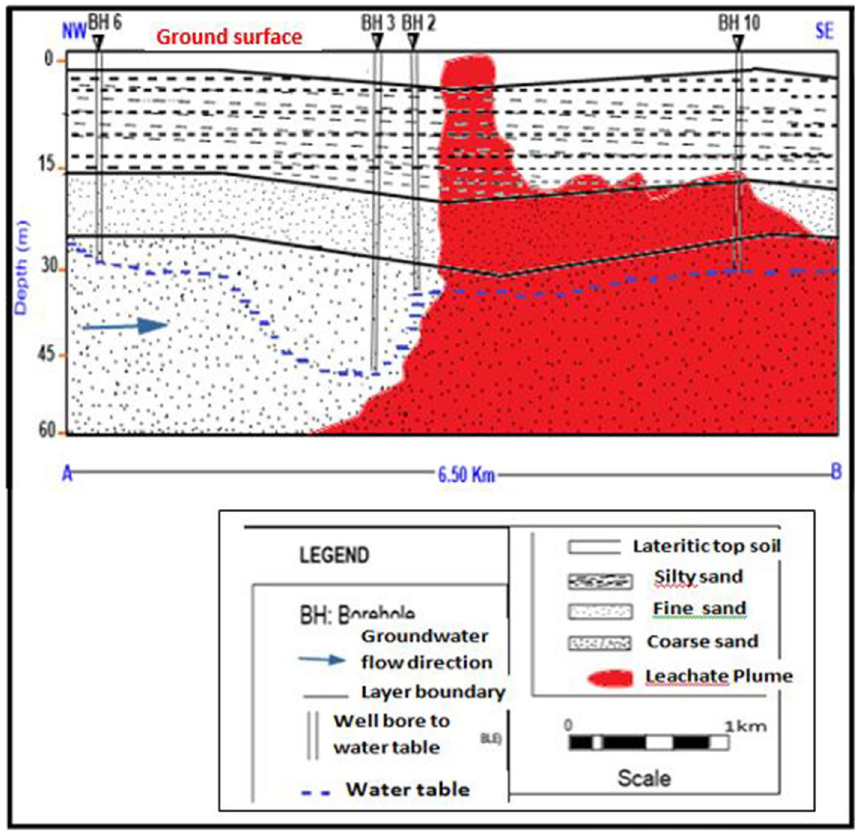
Figure 11. Generalized subsurface architecture of study area showing a cross section of the different measured parameters (leachate plume, water table and geoelectric layers) of the study